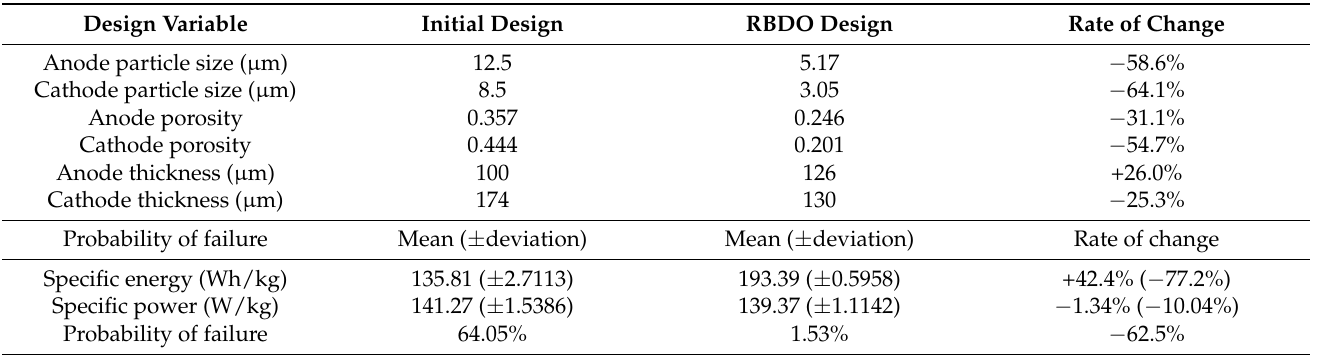
Table 3. Comparison of design variables and probability of failure between the initial and optimized designs. Design